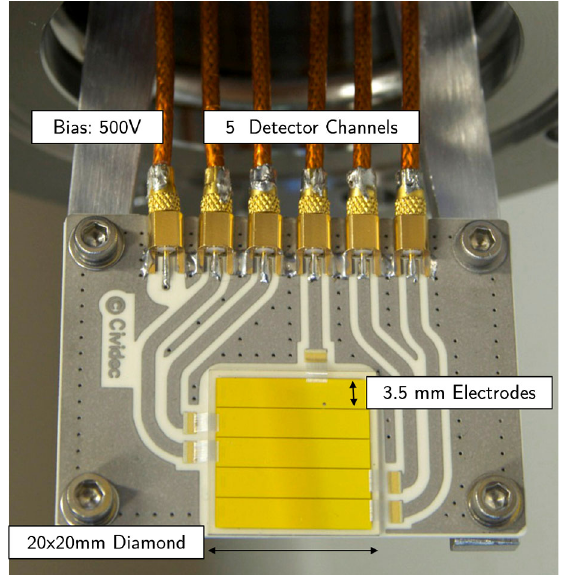
FIG. 7. pCVD diamond detector with 5 strip electrodes [21].